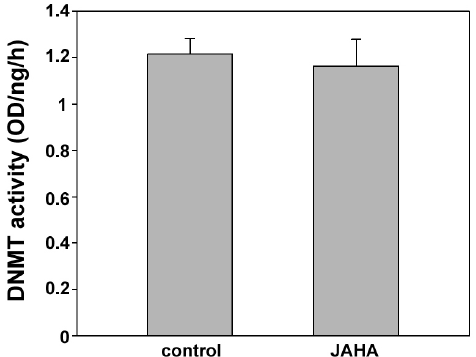
Figure 4. Enzyme ‐ linked immunosorbent assay (ELISA) assay of DNMT activity. Histogram showing the Figure 4. Enzyme-linked immunosorbent assay (ELISA) of DNMT activity. Histogram showing the methyltransferase activity of nuclear extracts of MDA ‐ MB231 cells in control and JAHA ‐ exposed methyltransferase activity of nuclear extracts of MDA-MB231 cells in control and JAHA-exposed conditions. The results are expressed as means ± s.e.m. of three independent ELISA assays. conditions. The results are expressed as means ˘ s.e.m. of three independent ELISA assays. Statistical Statistical analysis was performed with SigmaPlot 11.0 (Systat Software Inc.). OD: Optical density. analysis was performed with SigmaPlot 11.0 (Systat Software Inc.). OD: Optical